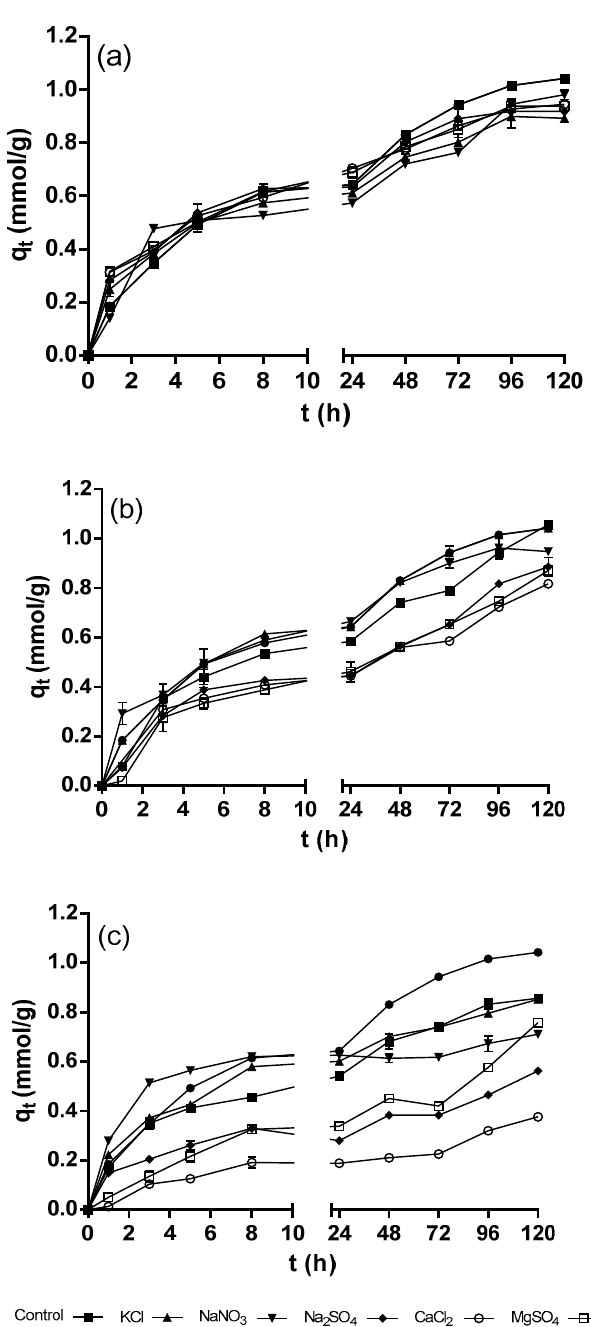
Figure 2. Effect of background electrolytes at a concentration of ( a ) 0.2 mM, ( b ) 2 mM, and ( c ) 20 mM on the biosorption of Ni 2+ by QCS.